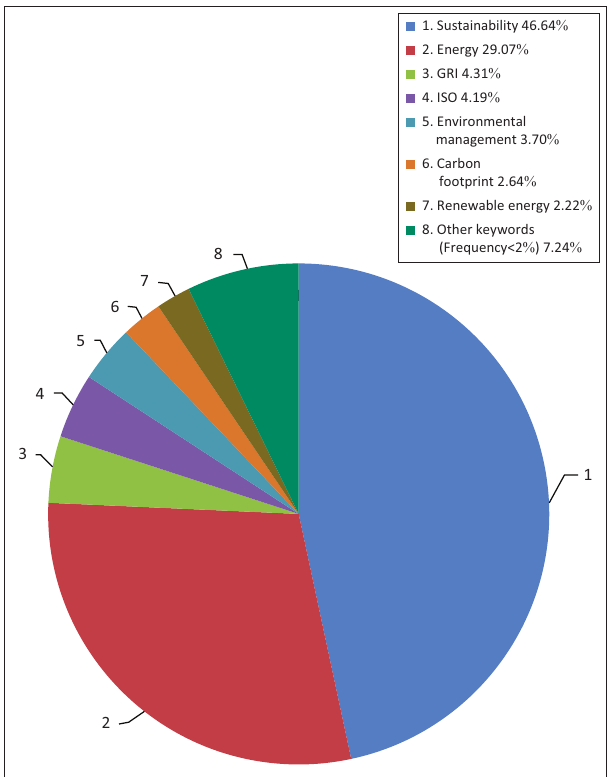
FIGURE 2: Relative frequency of sustainability-related